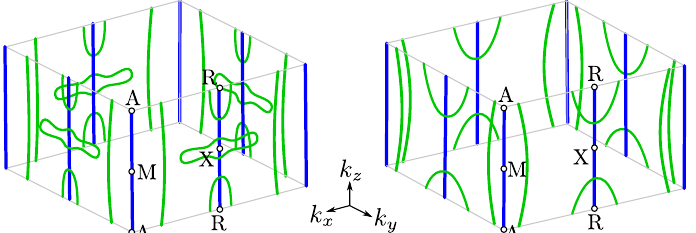
Figure 4. Location of nodal lines in k -space with respect to the first Brillouin zone (gray box). Actual, variable binding energy is not indicated. Blue solid lines are realized due to the system symmetry (sample range of energies are presented in Figure 3d). Similarly, green solid curves are realized as a consequence of the spin–orbit splitting vanishing at the Brillouin zone boundary (in X–R–A–M planes). Green lines are located at binding energies in ranges from − 1 to − 2 eV, and from − 0.5 to − 1.0 eV, for the left and right panels, respectively.